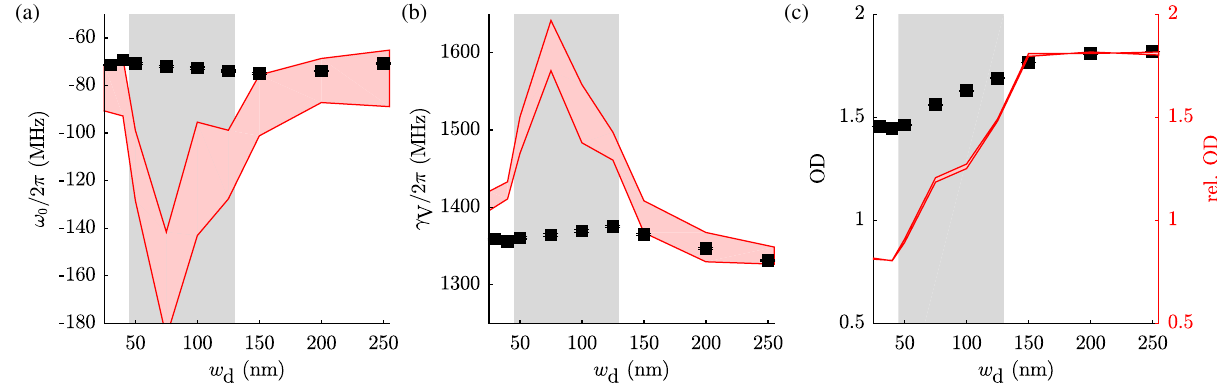
FIG. 3. Line shape parameters of the experimental spectra and Monte Carlo simulation results versus design slot width w d . Black squares show experimental data and the red areas correspond to simulation results, taking into account the uncertainty of the CP potential calculations. The gray shaded area indicates the interval 50 nm ≤ w d ≤ 125 nm, where the slot is not yet completely developed. (a) Center frequency ω 0 of the D 2 spectrum relative to the center frequency obtained in a reference cell. (b) Voigt width γ V (FWHM). (c) Optical depth of the Rb 85 5 S 1 = 2 ; F ¼ 3 → 5 P 3 = 2 ; F ¼ 4 transition. The simulation results for the OD are normalized to the maximum values of the measured OD and presented as relative OD (right ordinate) for a better comparison with the experimental